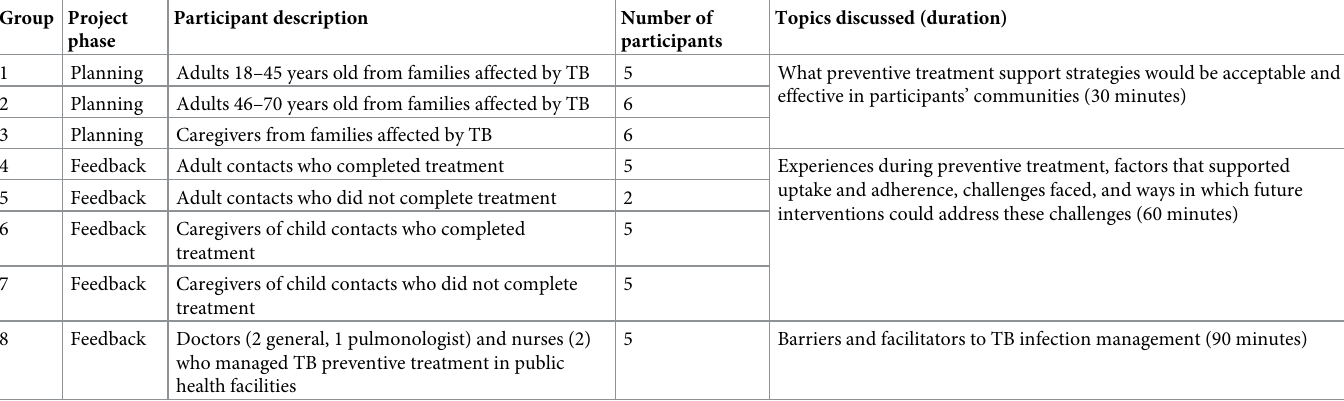
Table 1. Description of focus group